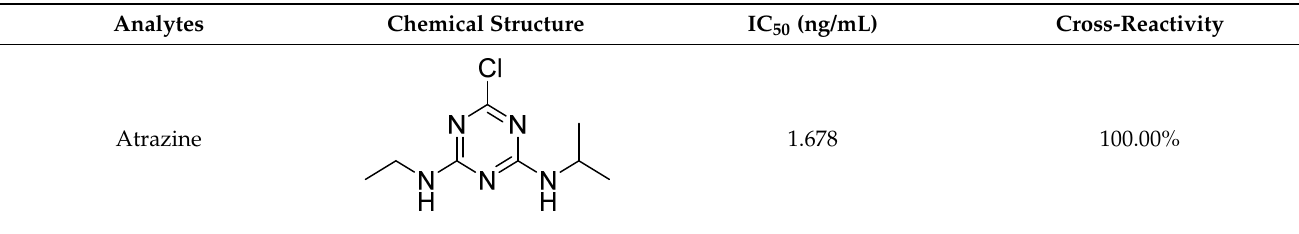
Table 5. Structures of triazine herbicides and their cross-reactivity rates.